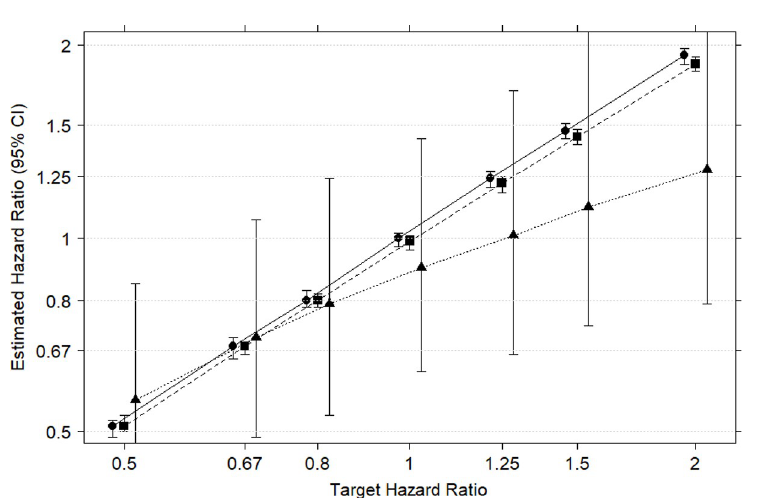
Fig 3. Estimates of the HR of smoking 5 years prior to diagnosis on post-diagnosis survival from simulated data sets. Three CIs are presented at each target HR. The first (denoted by circles joined by a solid line) are the estimated HRs obtained from Cox regression where ‘true’ smoking status and age are predictors of survival time. The second CIs (squares connected by a dashed line) shows the estimated HRs for ‘true’ smoking status after age-standardisation of survival times. The third set of CIs (triangles connected by a dotted line) shows the estimated HR for imputed smoking status after age standardisation (I2C2).